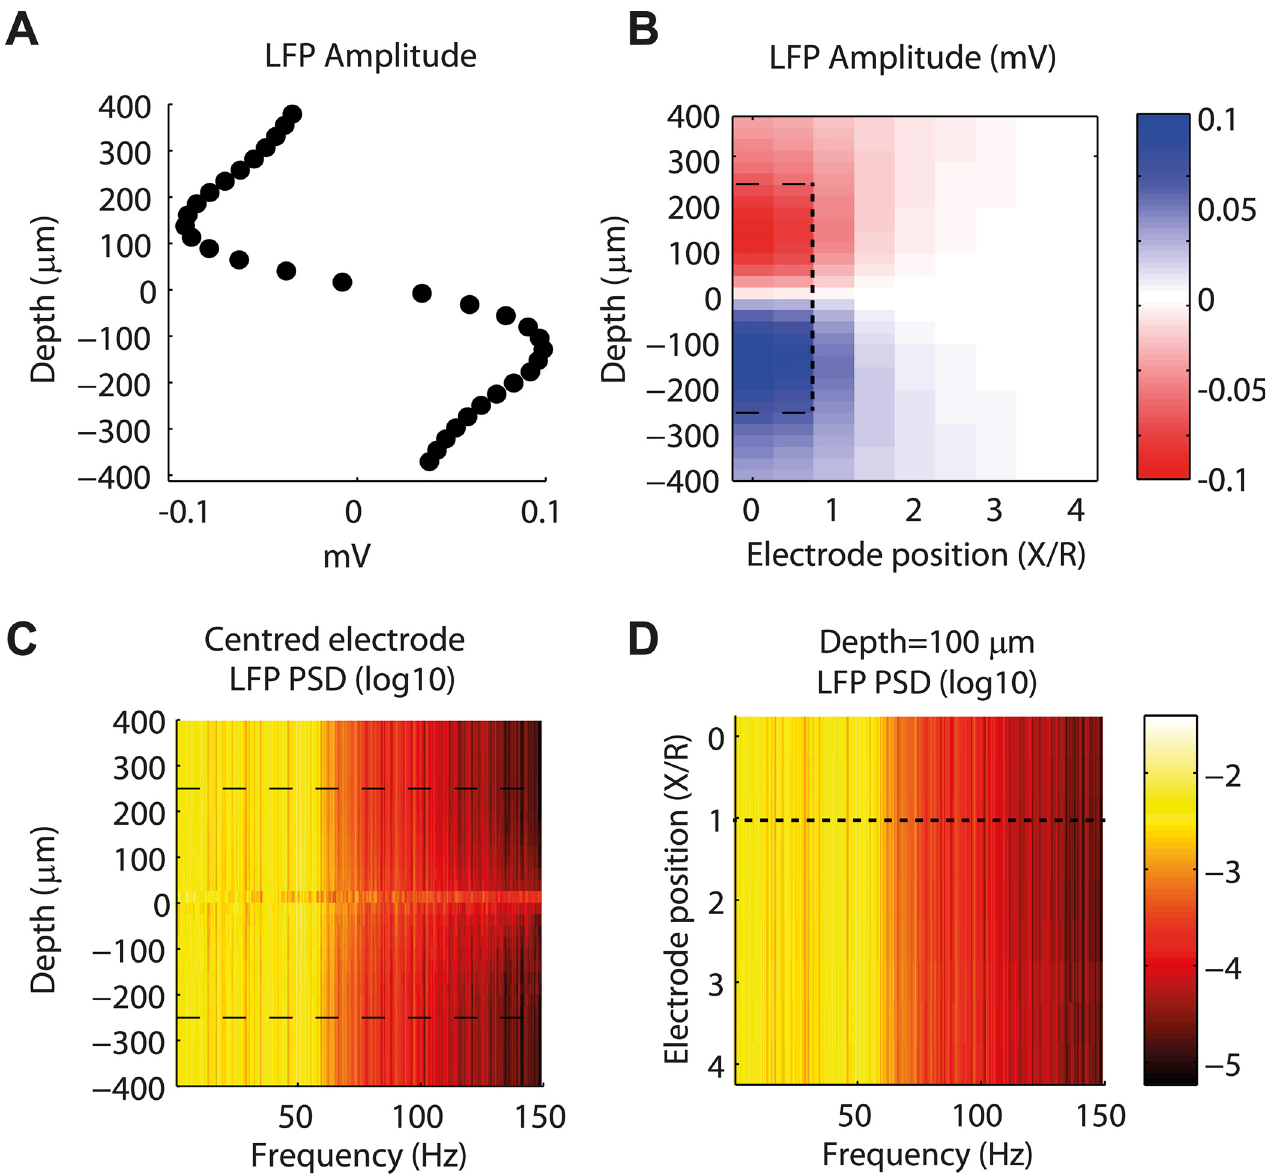
Fig 2. Simulated local field potentials (LFPs) as a function of depth and lateral position of the electrode from the center of the 3D network. (A) Amplitude of LFP signal generated by the morphological 3D network at 50 μ m spaced depths, when the dynamics were driven by a 10 seconds thalamic input of 1.5 spikes/ms. The amplitude was measured as the standard deviation of the LFP signal over the entire time course with the same sign as the baseline (see Fig 1E). Dashed lines indicate network boundaries (-250 μ m < d < 250 μ m) (B) Amplitude of LFP signal at different depths and distances from the center of the 3D network. Distances were measured in units of 3D network radius R (= 250 μ m). The dashed lines separate the area inside the network ( X / R (cid:4) 1 & -250 μ m < d < 250 μ m) and outside the network. (C) Power spectral density (PSD) of LFP signal in the center of the 3D network for different depths. Dashed lines indicate network boundaries -250 μ m < d < 250 μ m). (D) Power spectral density (PSD) of LFP signal at different distances from the center of the 3D network at a reference depth of 100 μ m. Dashed line indicates network boundary ( X / R =